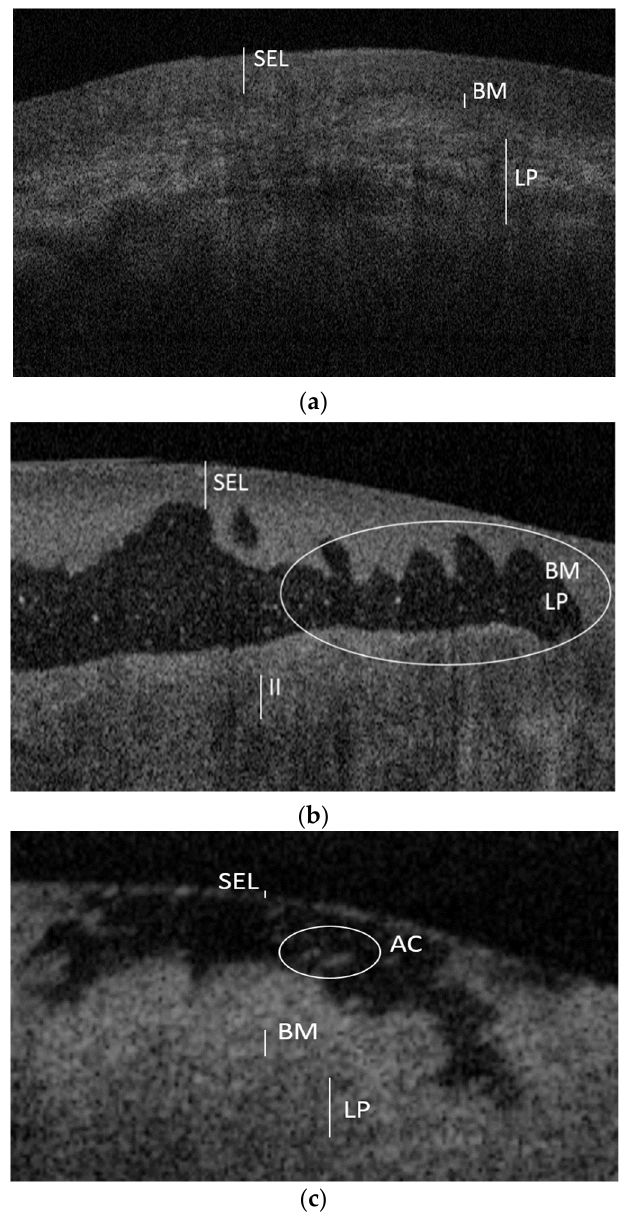
Figure 2. OCT images of normal gingival mucosa (a), gingival mucosa with MMP (b) and gingival mucosa with PV (c). Compared to the healthy mucosa (a), in the DG by MMP (b) there is the presence of a multilocular subepithelial blister, together with a dense inflammatory infiltrate (II) underlying an altered profile of both the basement membrane (BM) and the lamina propria (LP). In the DG by PV (c) there is a unilocular intraepithelial blister which reduces the thickness of the stratified epithelial layer (SEL); it is also possible to observe acantholytic cells (AC) inside the blister. OCT pattern for